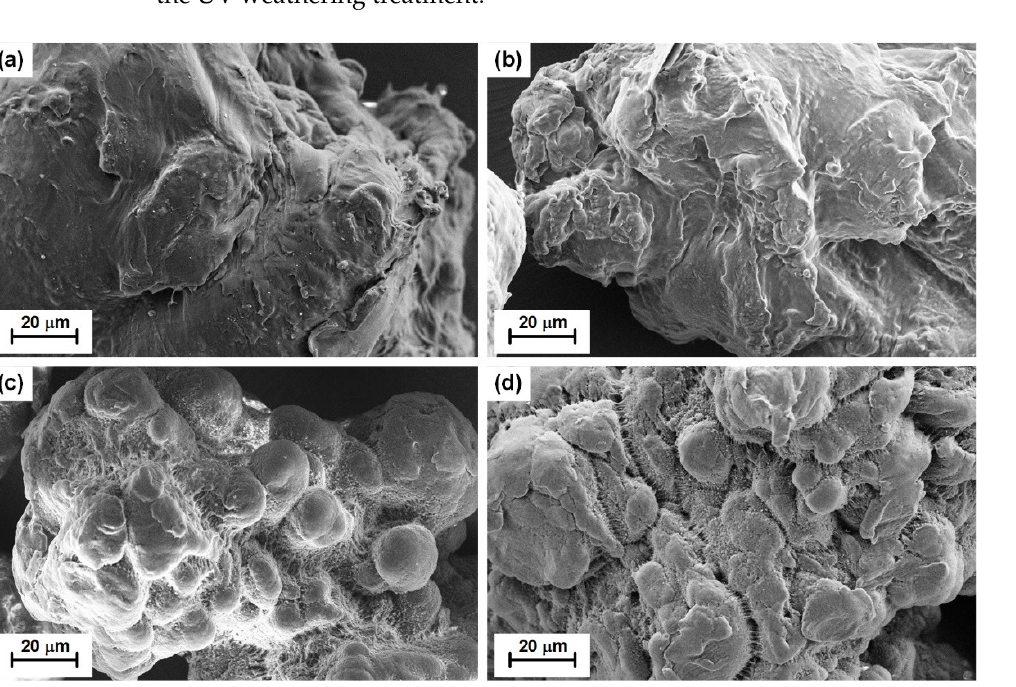
Figure 1. SEM images of polyethylene microplastics (PE MPs) ( a )—pristine low-density polyethylene (LDPE); ( b )—UV-weathered LDPE; ( c )—pristine high-density polyethylene (HDPE); ( d )—UV-weathered HDPE). Table 1. Volumetric median diameters ( D v 50 ), Brunauer-Emmett-Teller (BET) surface areas, oxygen-to-carbon (O/C) atom ratios of pristine and UV-weathered polyethylene MPs (mean ±